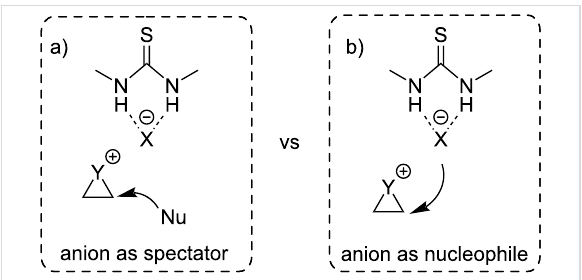
Figure 3: Role of the counter-anion: a) Anion acting as a spectator and b) anion participating directly as the nucleophile.